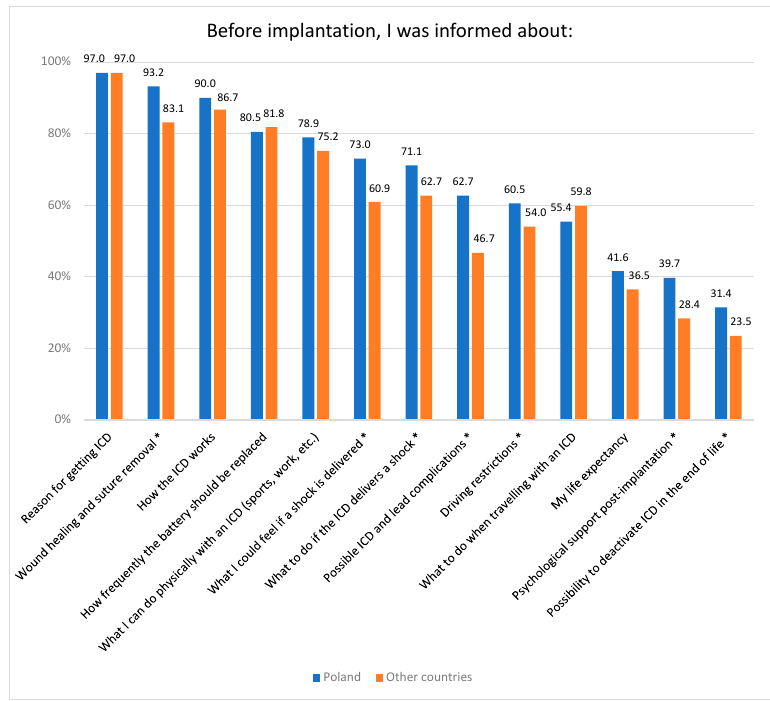
Figure 1. Information provided to patients according to cohorts. * p < 0.05.